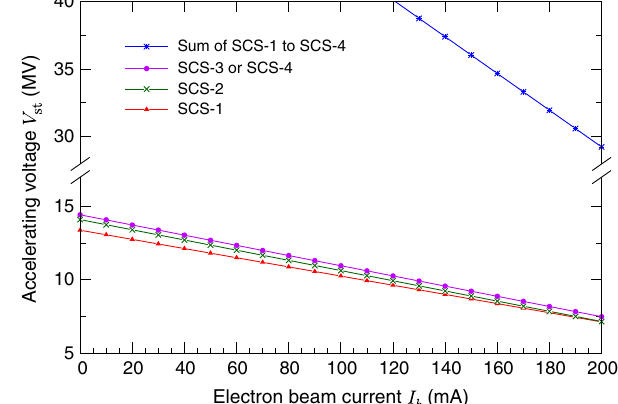
TABLE VI. Cavity figures of merit obtained from SUPERFISH . Figure of merit